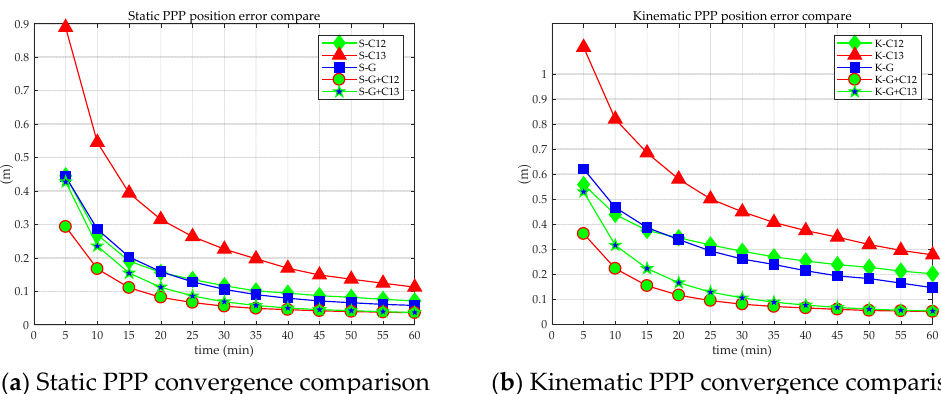
Figure 11. Positioning convergence in the first hour of static ( a ) and kinematic ( b ) PPP.